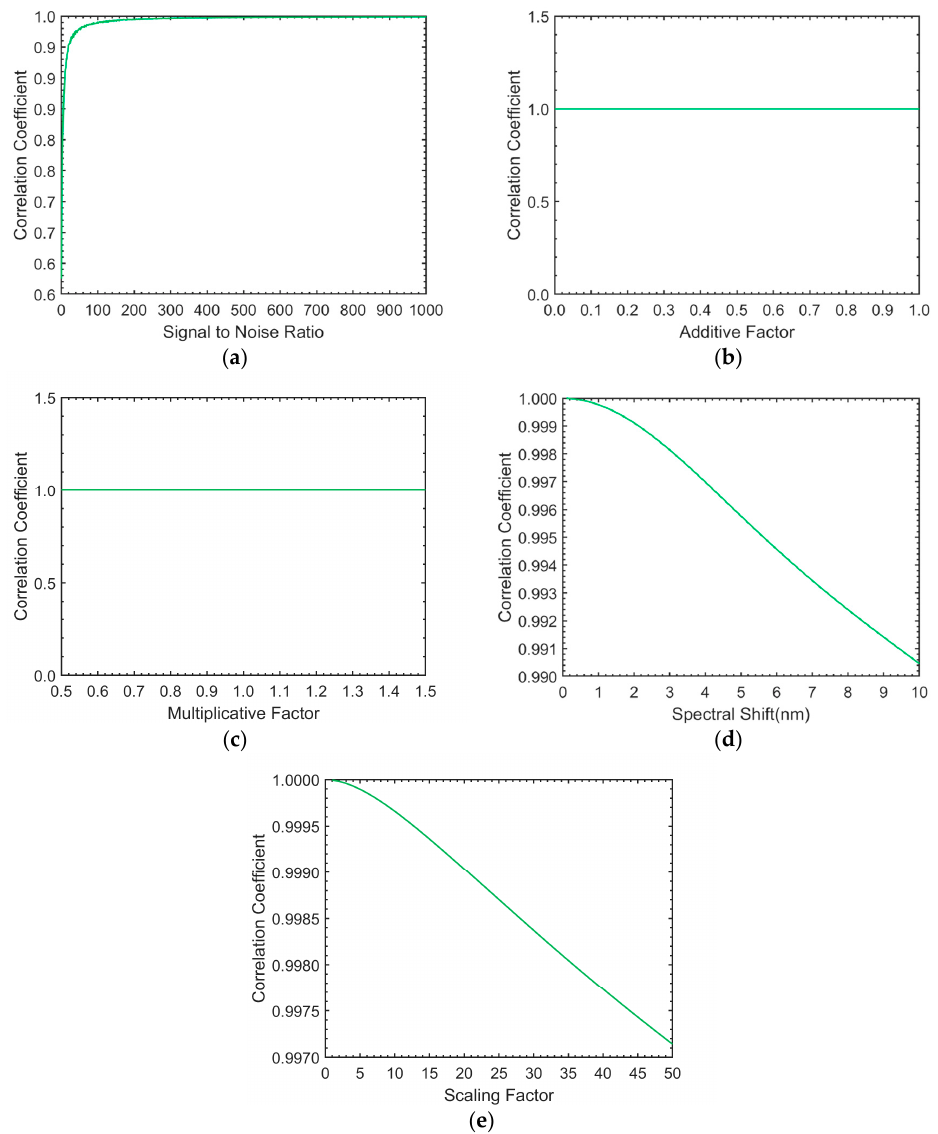
Figure 10. The CC between R ( λ ) and each of the transformed datasets, R t ( λ ) . ( a ) The CC asymptotically reduced from one when the SNR decreased through the introduction of AWGN. ( b ) The CC was invariant to additive transformations. ( c ) Multiplicative transformations had no impact on the